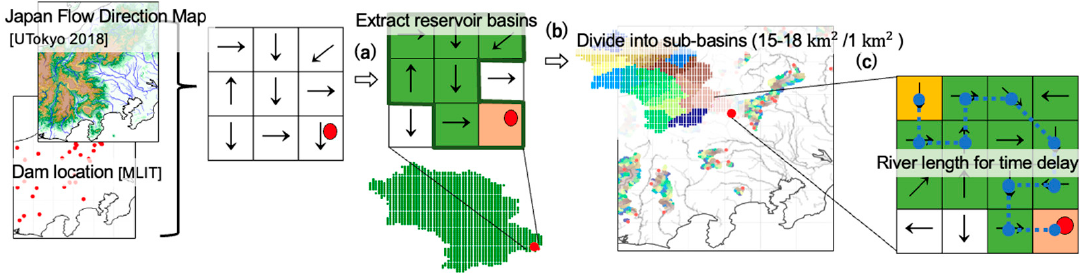
Figure 4. Schematic diagram of the methods used to obtain reservoir basins’ information. In order to obtain the hourly rainfall (mm/h) of each sub-basin, the association of rainfall grid data with the catchment grids and averages over each sub-basin was under- taken.